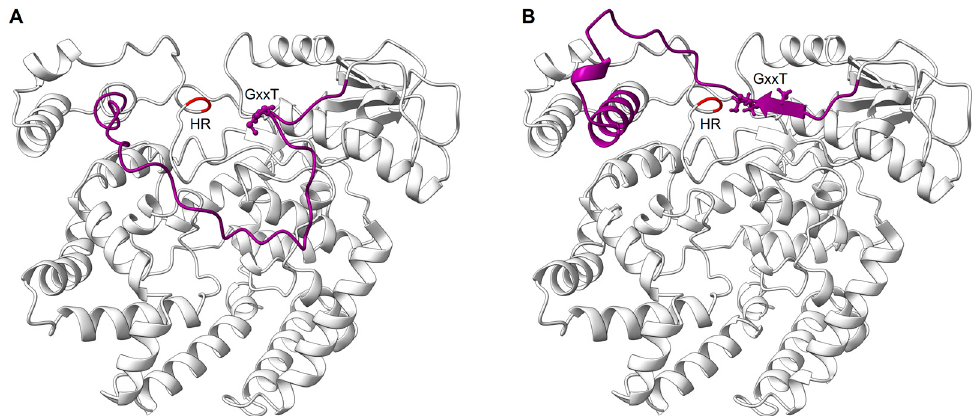
Figure 6. Snapshots of the PRNTase priming loop in initiation and elongation-compatible positions. The PRNTase domain is shown as light gray ribbons with the catalytic HR residues colored in red. The priming loop is shown in dark violet with the GxxT motif highlighted as spheres. The panels show snapshots of the priming loop in two different conformations—( A ), down and ( B ), up—with respect to the RdRp domain as defined by the box in Figure 5A. This conformational change is presented in Video S1 evidencing the rearrangement undergone by the PRNTase domain. The priming loop in the down position is associated with an initiation compatible mode of the L protein for RNA